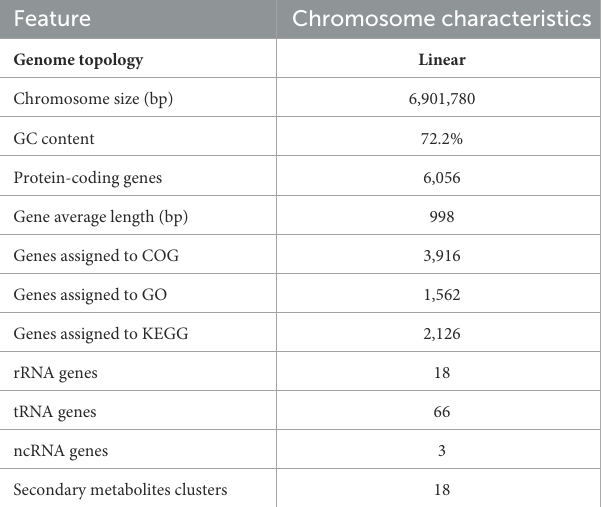
TABLE 4 Genome features of strain HNM0140 T